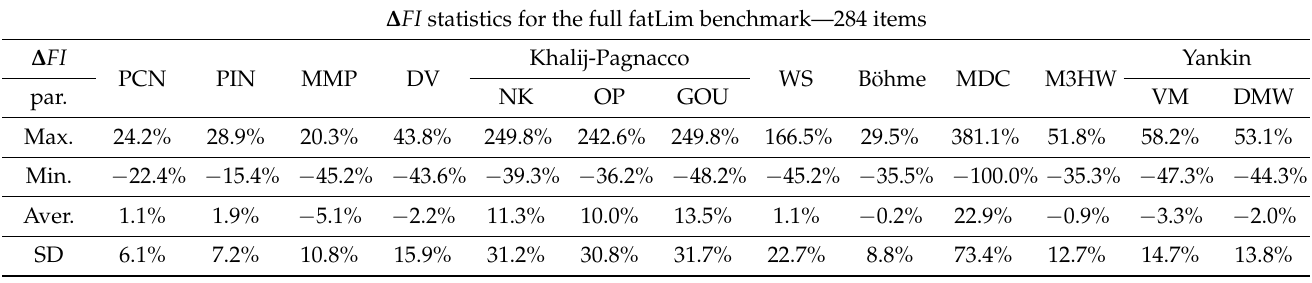
Table 10. Summary of the ∆ FI statistics for various configurations of the evaluated benchmark sets. ∆ FI statistics for the full fatLim benchmark—284